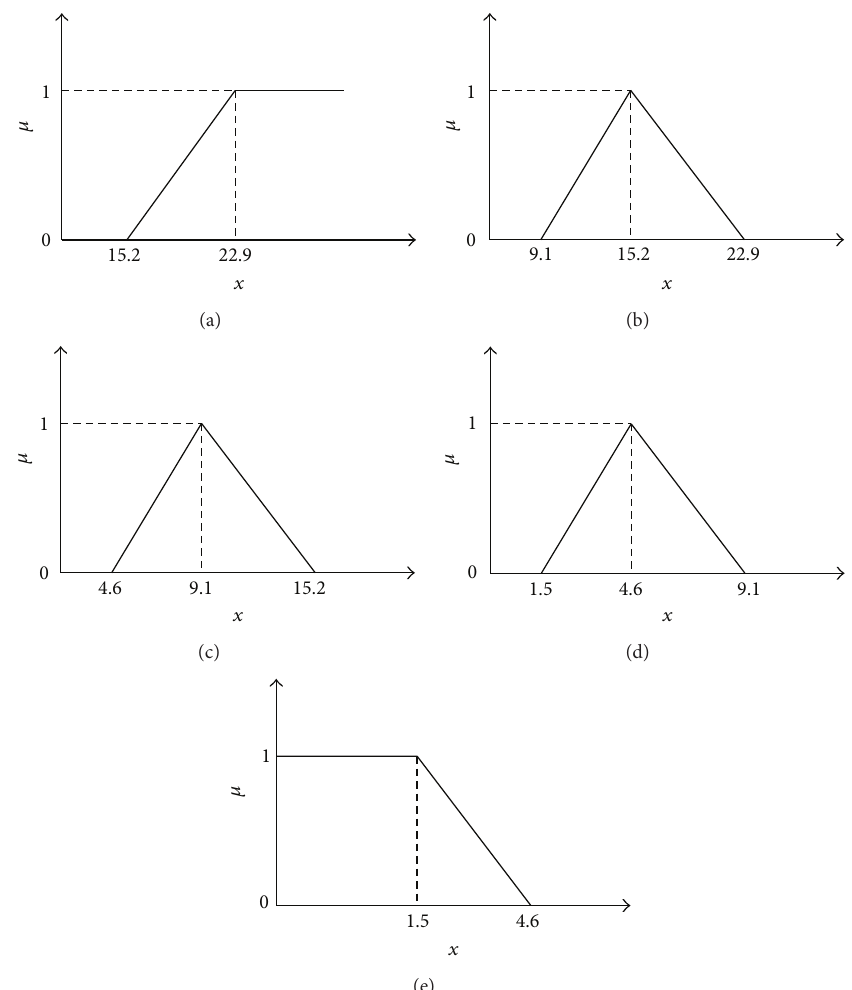
Figure 2: Triangular membership functions of depth of the aquifer ( 𝐷 ).